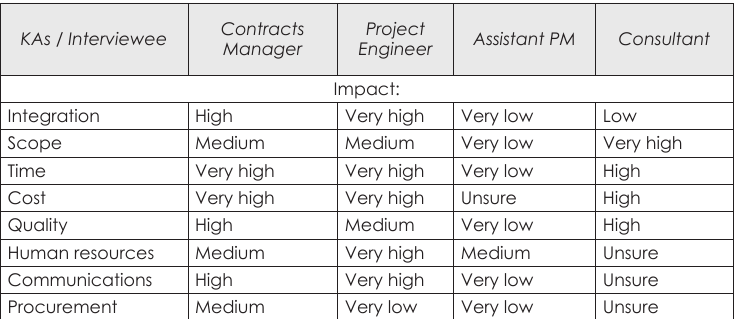
Risks’ impact perceptions on the other PMI knowledge areas in Case 2